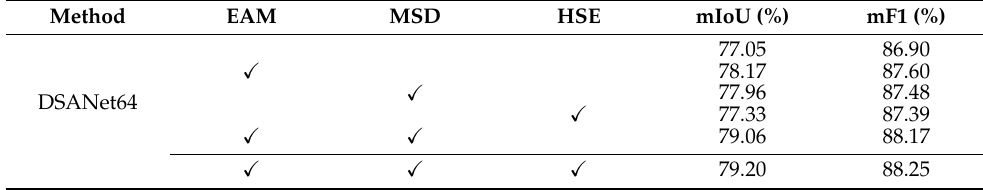
Table 7. Results of the Ablation Study Conducted on the Potsdam Dataset.